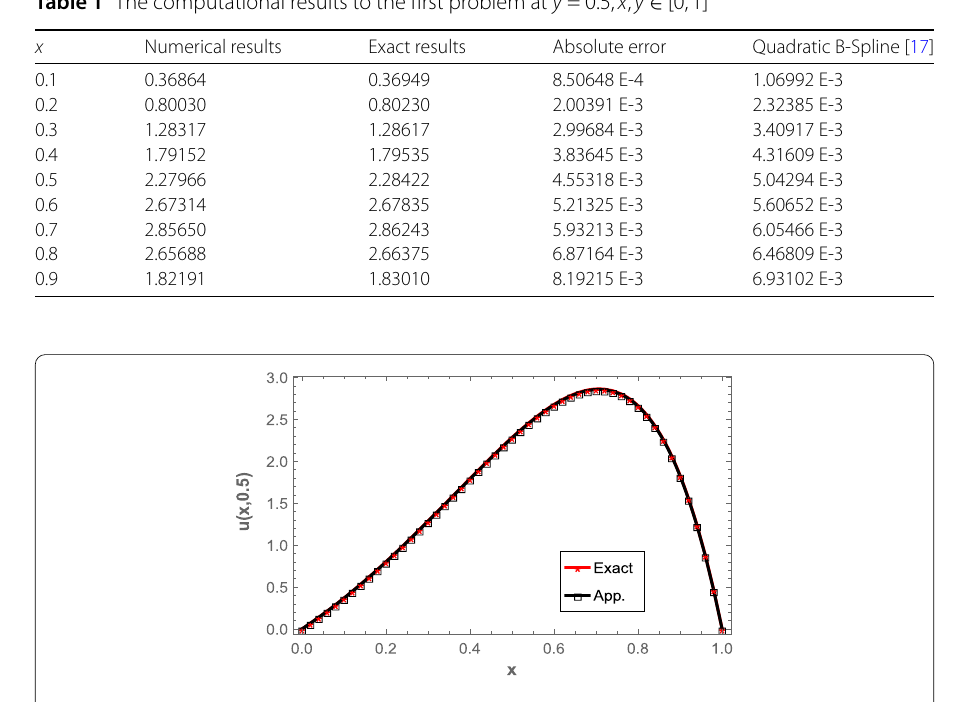
Figure 1 The exact results at y = 0.5 and the numerical